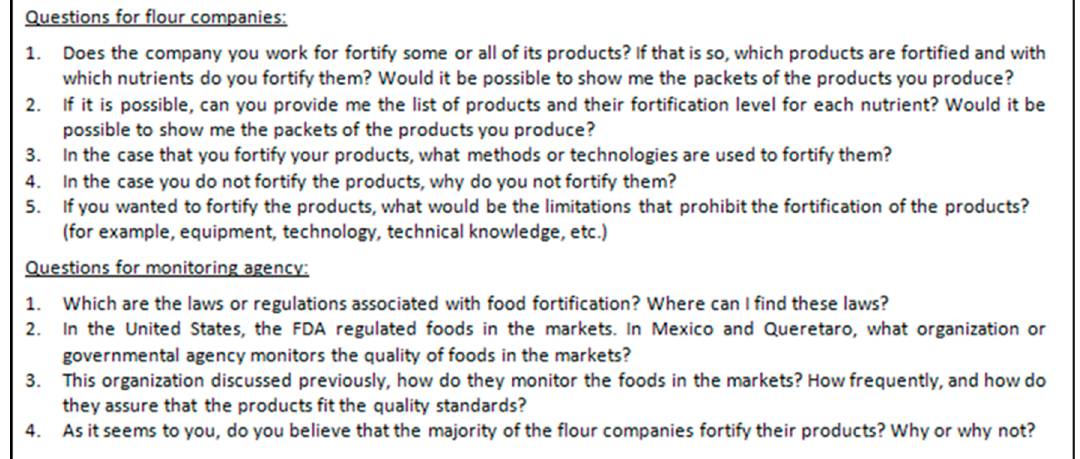
Figure 2. Interview questions translated to English for flour companies (n = 5) and monitoring agencies (n = 4).